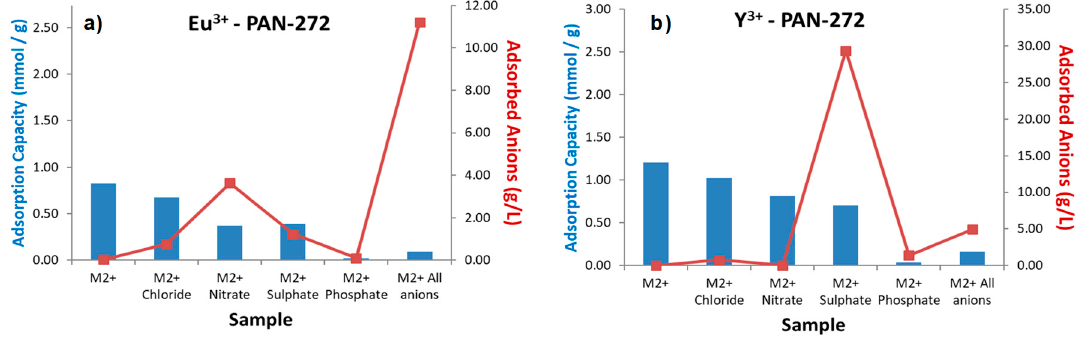
Figure 9. Selective adsorption of ( a ) Eu(III) and ( b ) Y(III) in presence of aqueous solutions of interfering anions with a concentration of 0.25 M (molar ratio 400:1 respect of total metal content in solution).